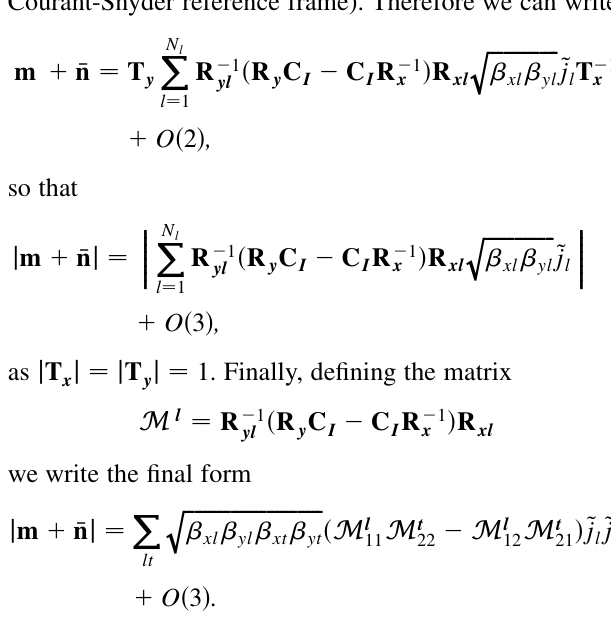
ffiffiffiffiffiffiffiffiffiffiffiffiffiffiffiffiffiffiffiffiffiffiffiffiffiffiffiffiffi